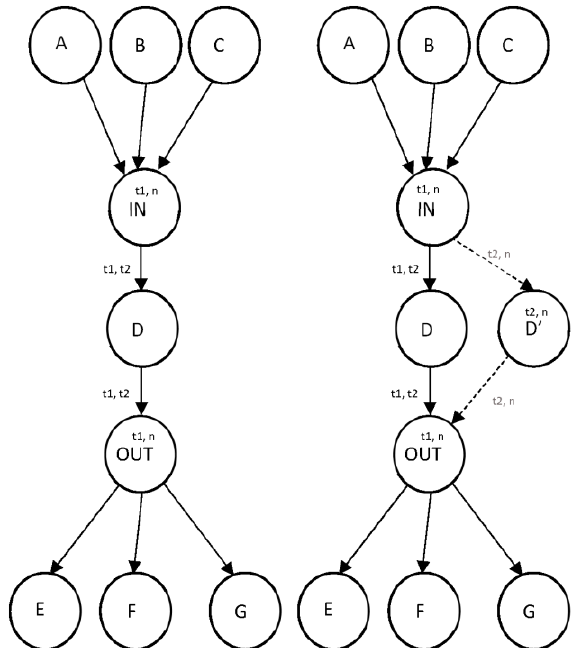
Figure 7. The third approach — adding proxy.